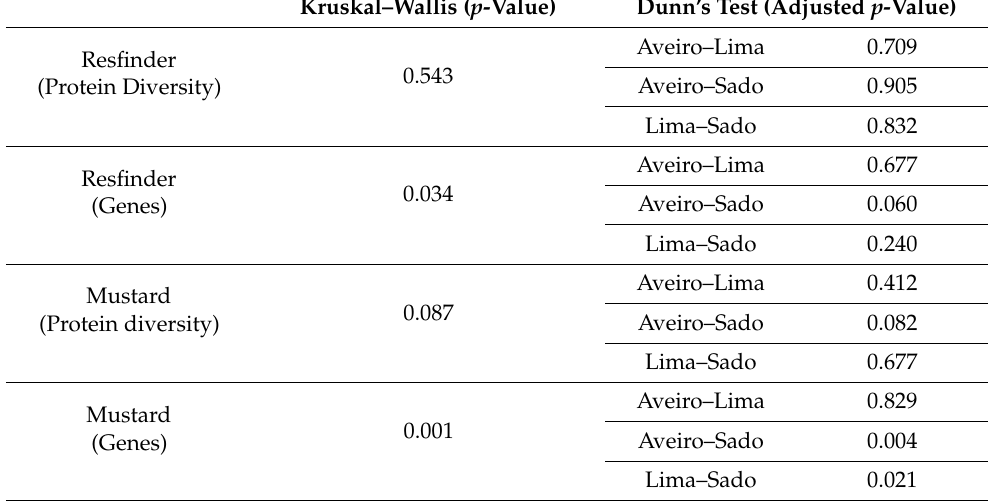
Table 1. Kruskal–Wallis and Dunn test